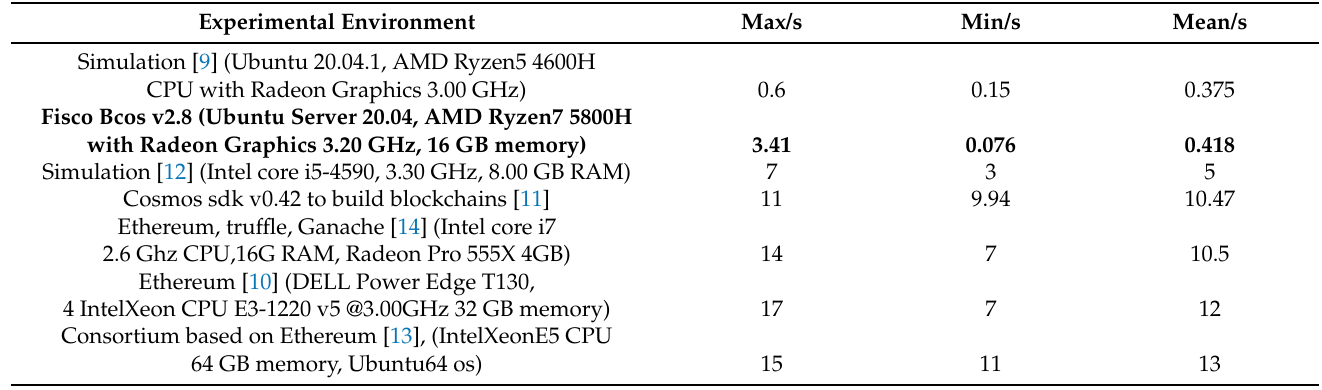
Table 1. Comparison of results of different platforms and cross-chain